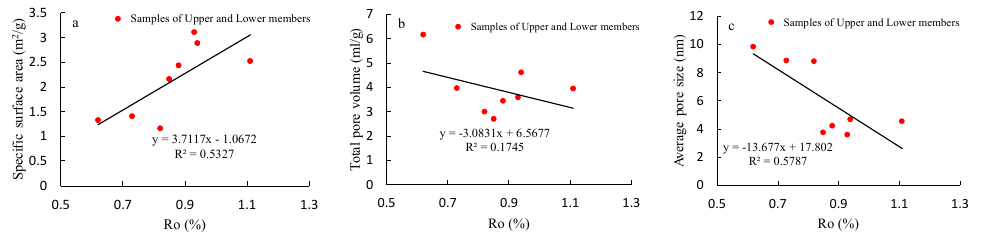
Figure 10. The relationship between pore structure parameters and vitrinite reflectance (R o ) in the Upper/Lower Bakken samples. ( a ) Specific surface area vs. R o ; ( b ) Total pore volume vs. R o ; ( c ) Average pore size vs. R